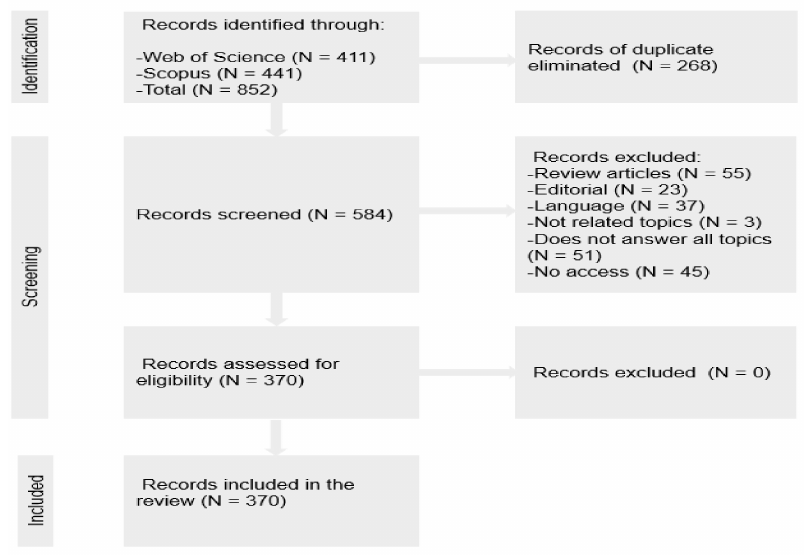
Figure 1. Flow diagram of the search and selection process of documents. Note: N indicates number of